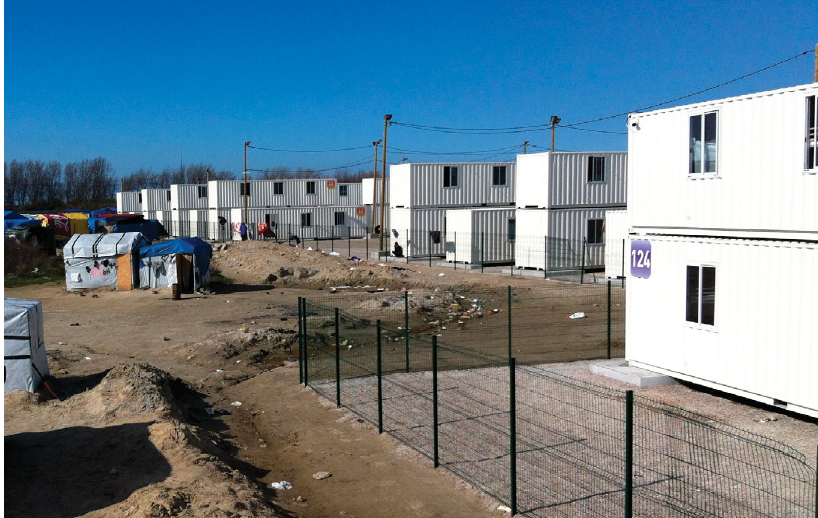
Figure 1. The container camp (right) and part of the “Jungle” camp (left) , Calais, France, April 2016. Photo by